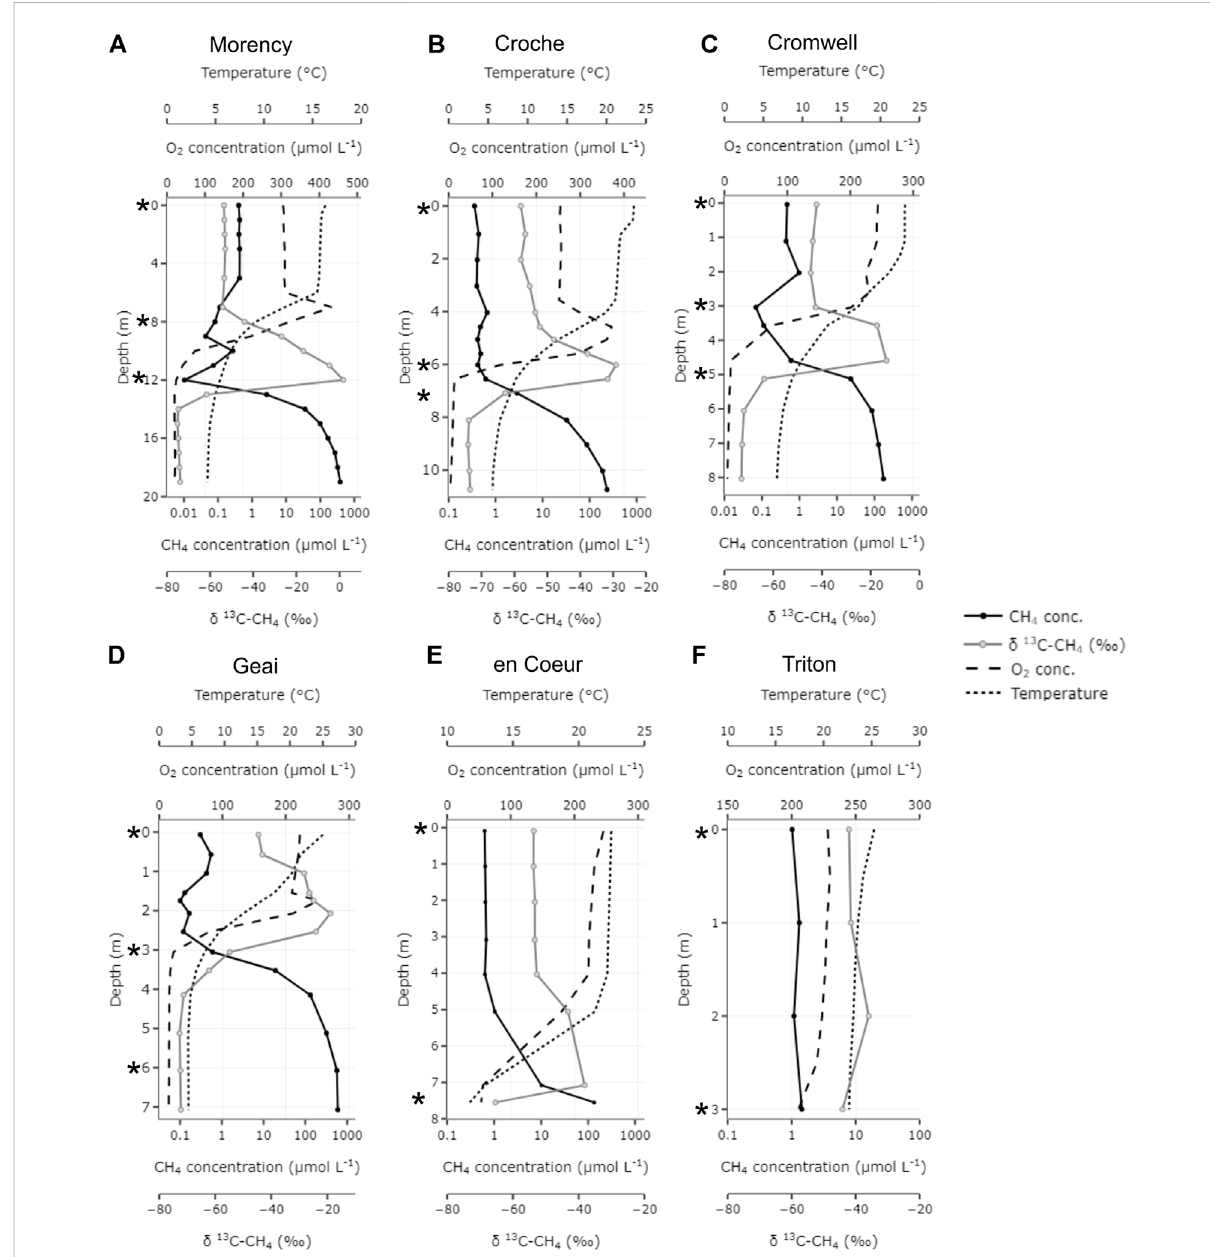
with buffered paraformaldehyde and fi ltered through 0.2 μ m polycarbonate fi lters (Millipore GTTP, 25 mm). The fi lters were kept frozen until microscopic analysis through Catalysed Reporter Deposition — Fluorescence In Situ Hybridization (CARD-FISH) with probes for aerobic MOB belonging to α - and γ -proteobacteria and epi fl uorescence microscopy (see Reis et al., 2020 for details). We used extensively applied CARD-FISH